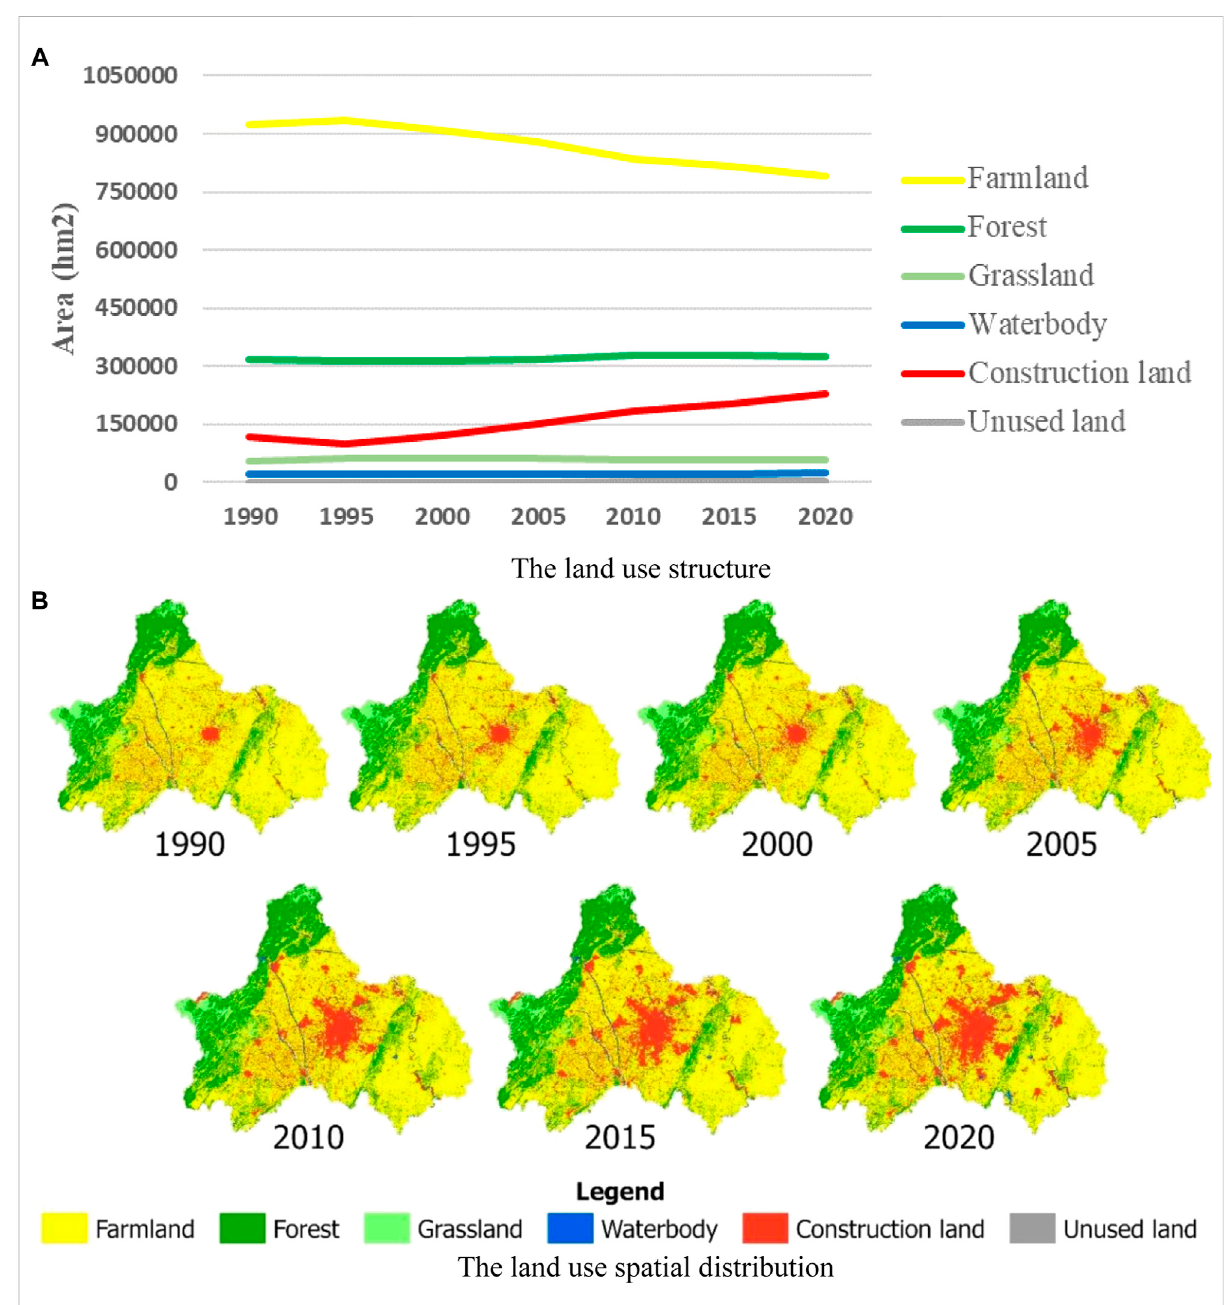
FIGURE 2 Spatiotemporal change of land use in Chengdu from 1990 to